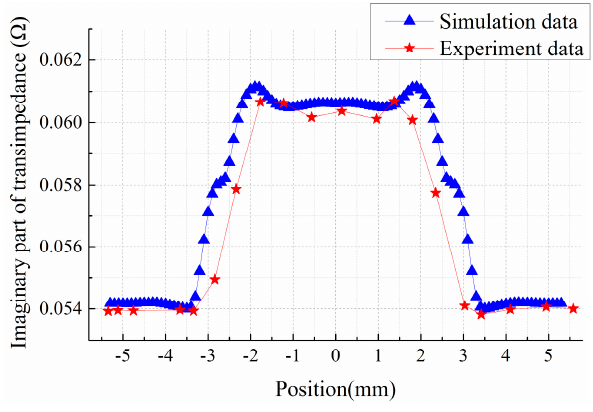
Figure 10. Response of crack 2 in H mode scanning.